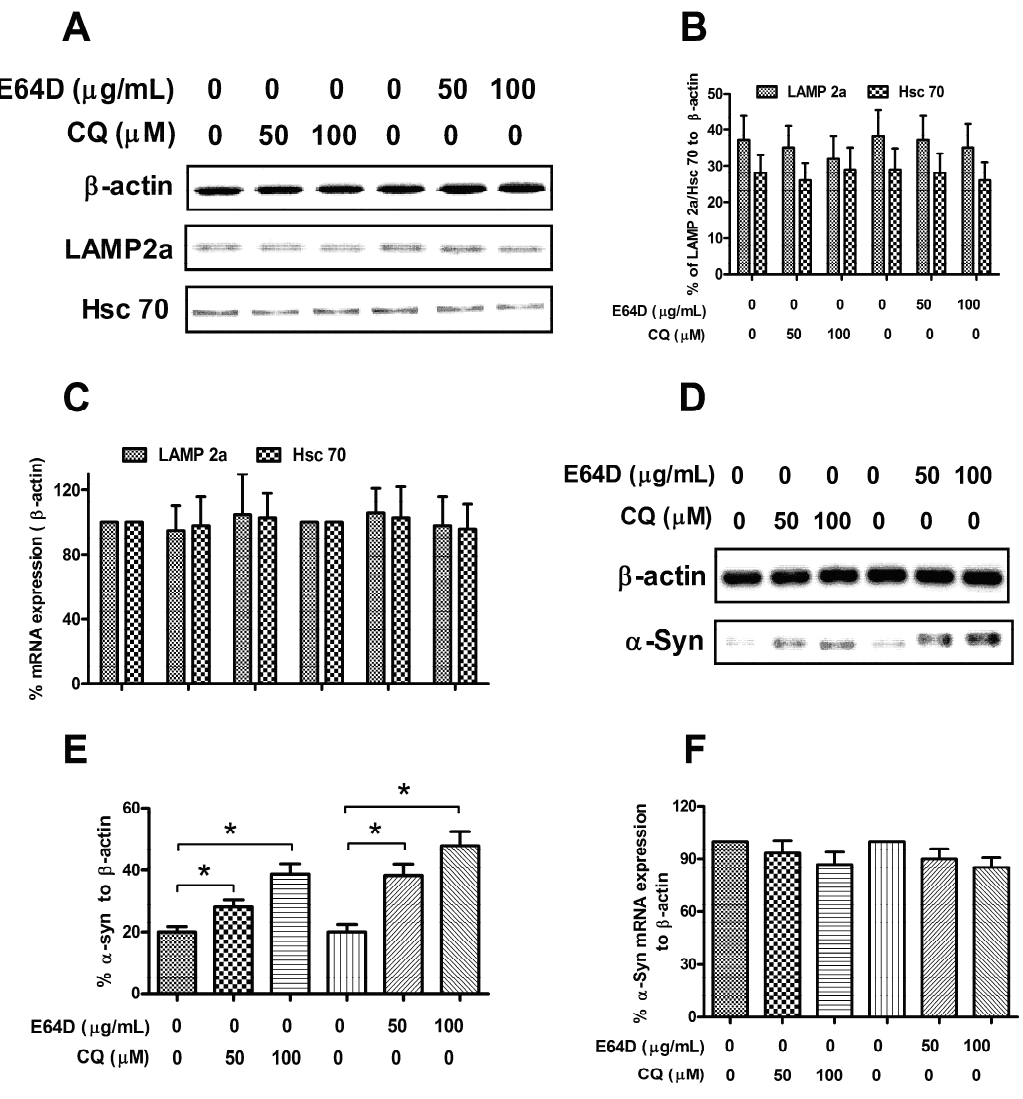
Figure 2. SH-SY5Y-Syn(+) cells are sensitive to the E64D or CQ. ( A ) Western blot analysis of LAMP2A and Hsc 70 expression in SH-SY5Y-Syn(+) cells post E64D or CQ treatment; ( B , C ) E64D or CQ treatment had no influence on the LAMP2A or Hsc 70 expression in protein level ( B ) and in mRNA level ( C ) in SH-SY5Y-Syn(+) cells; ( D , E ) Western blot analysis of the α -Syn accumulation in the SH-SY5Y-Syn(+) cells post E64D or CQ treatment; ( F ) α -Syn expression in mRNA level in SH-SY5Y-Syn(+) cells post E64D or CQ treatment. Data represent the mean ± SEM of three independent experiments. Statistical significance was considered with a p -value <0.05, * p <